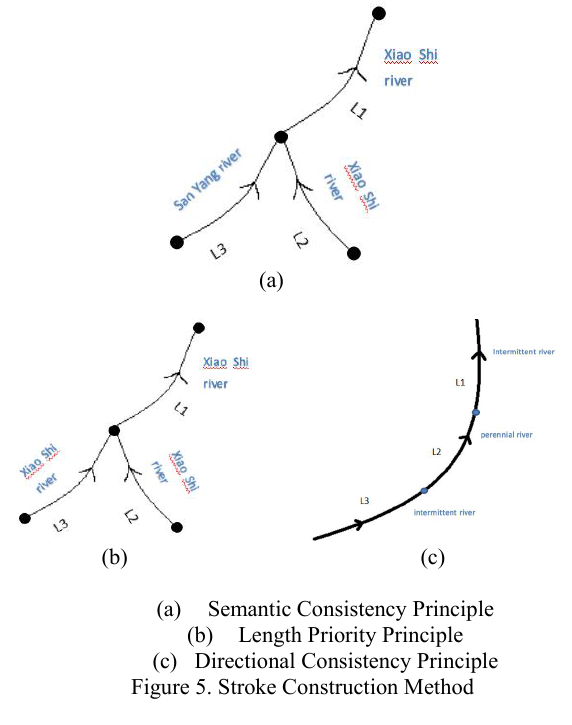
Figure 5. Stroke Construction Method